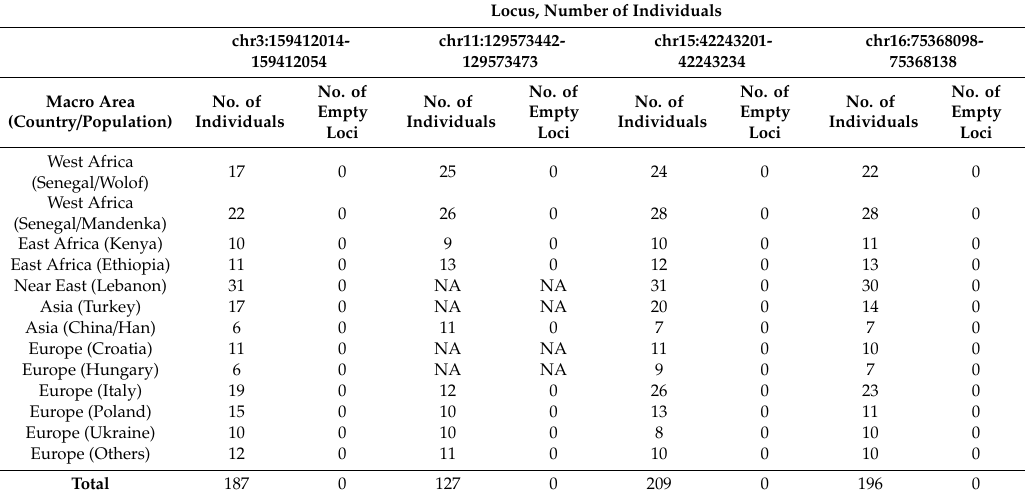
Table 1. Human-specific interstitial telomeric sequence (ITS) loci analyzed for insertion polymorphism. Coordinates of the loci, country of origin and number of individuals analyzed for each locus are indicated. NA, not